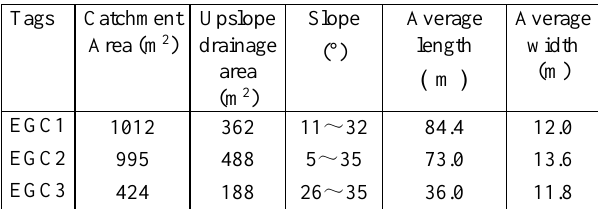
Table 1. Topographic characteristics of three ephemeral gully catchments